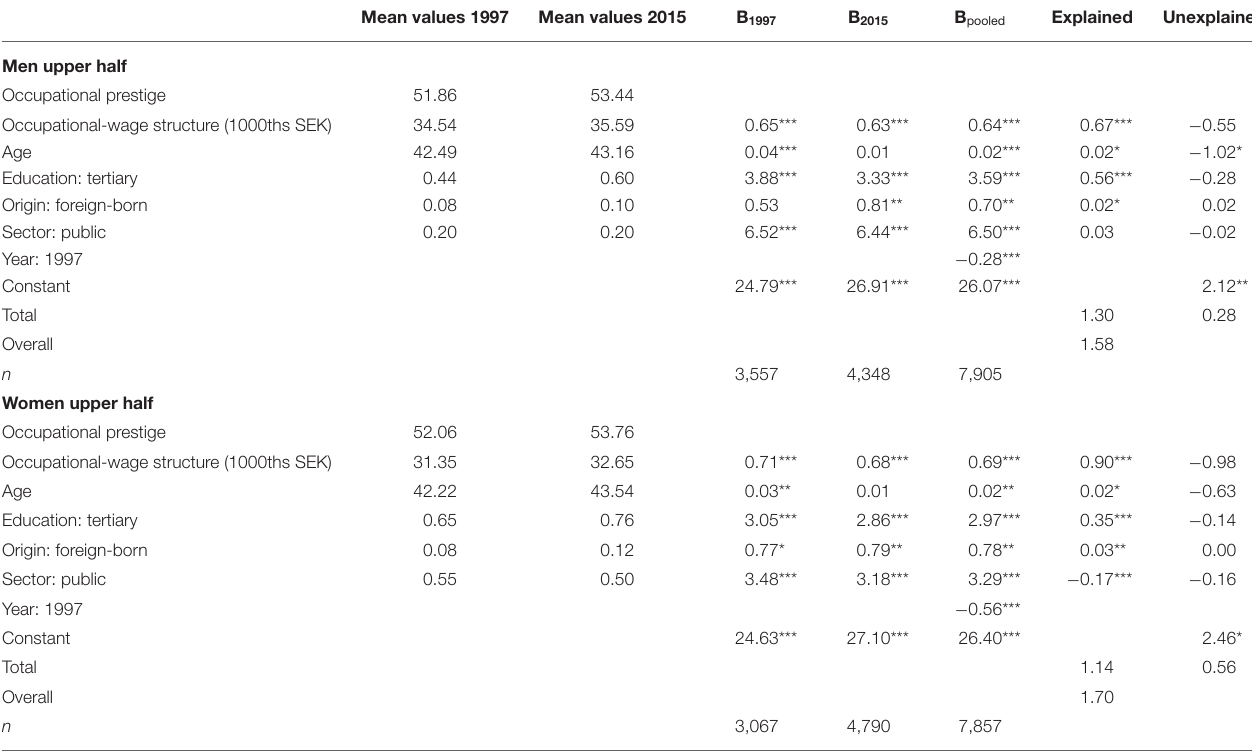
TABLE 3 | Blinder-Oaxaca decomposition of the change in occupational prestige for men and women in occupations above the median occupational prestige,